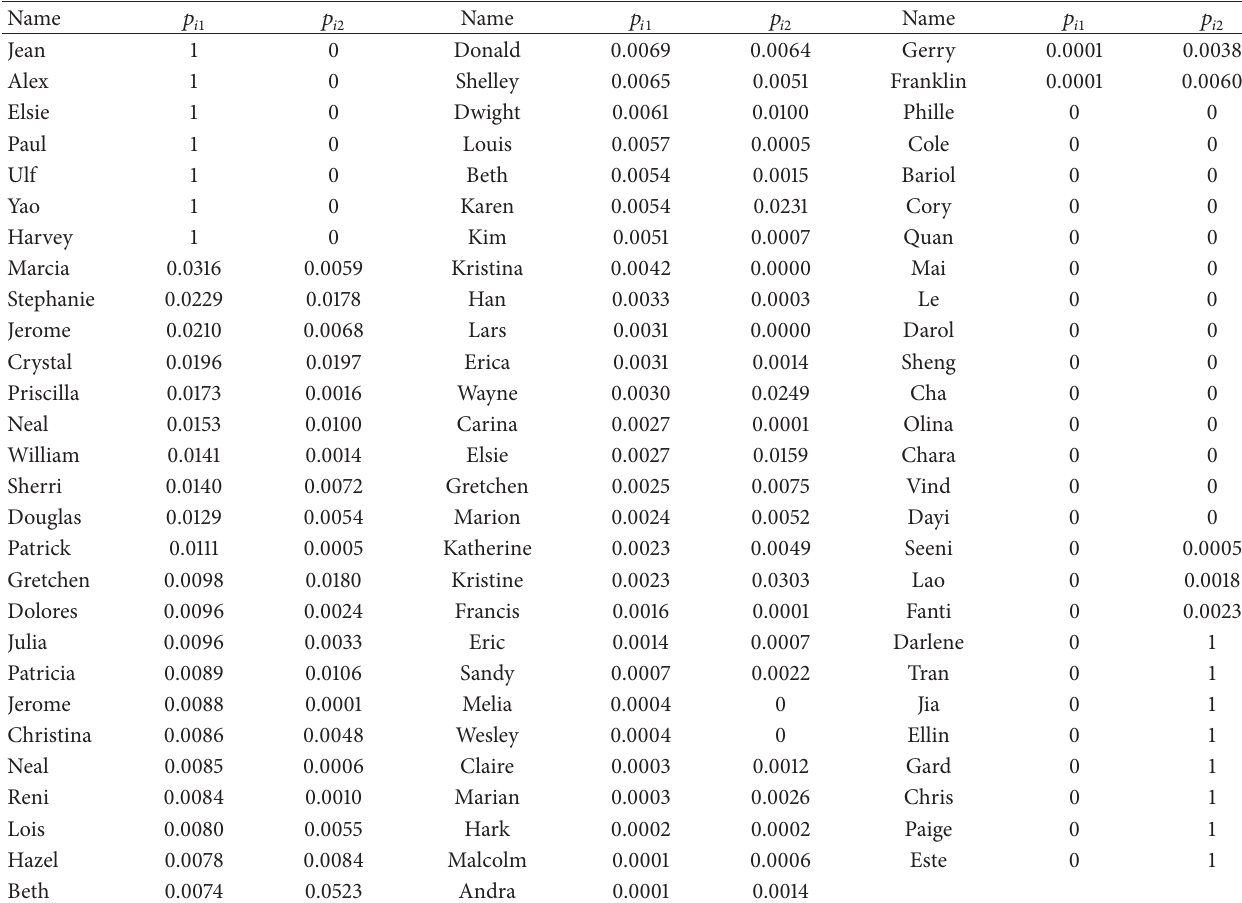
Table 3: Priority list of criminal